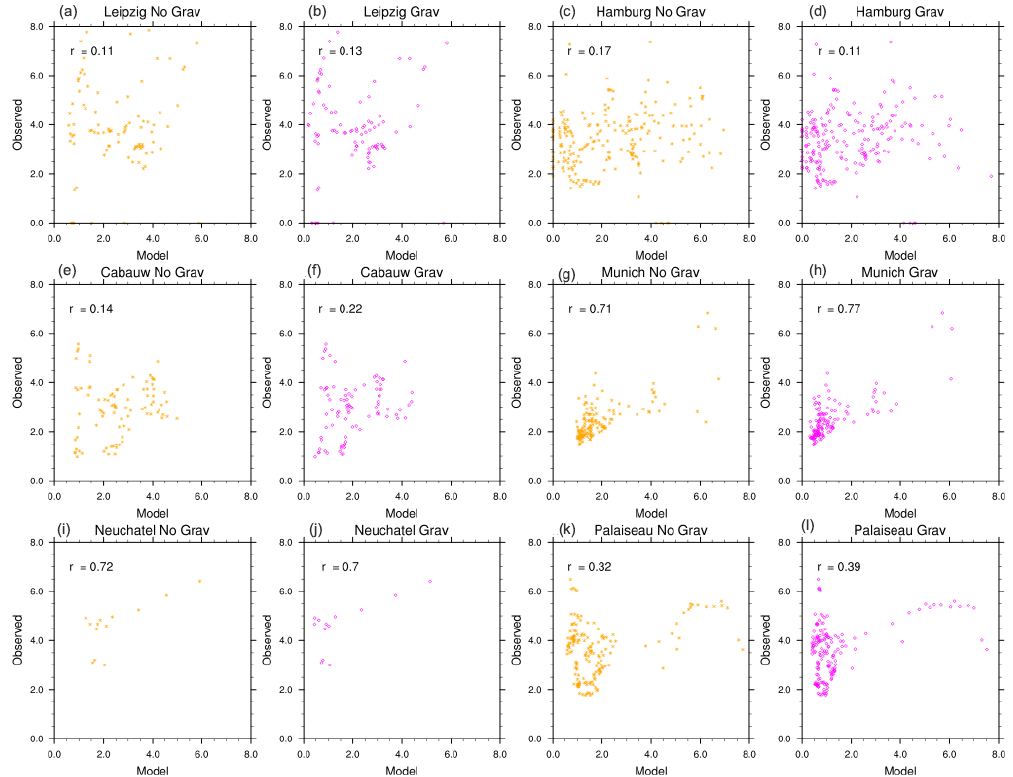
Figure 10. Scatterplots for observed versus simulated centres of ash mass with (magenta) and without (orange) gravitational settling. Data correspond to Fig. 8 using model and observed values under 8km but above the PBL. Correlation between observed and model values is given in the upper left